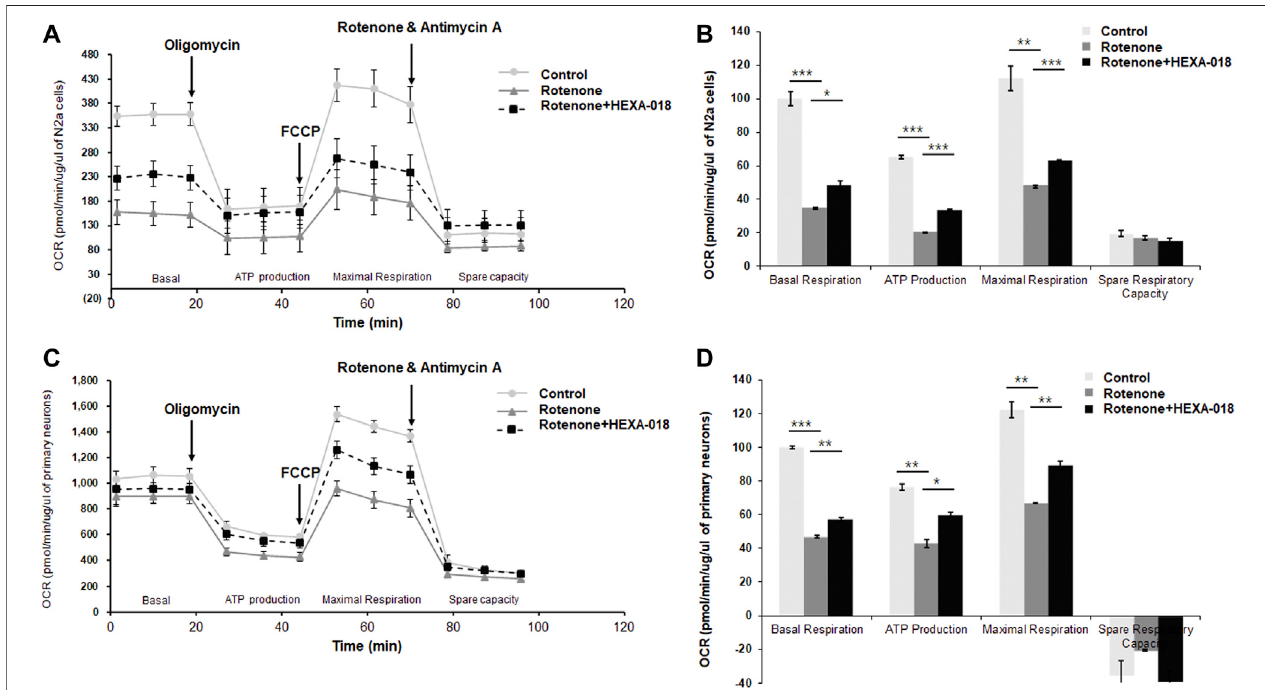
FIGURE 5 | HEXA-018 mitigates rotenone-induced mitochondrial dysfunction in neuronal cells. (A,B) N2a cells were pretreated with HEXA-018 (5 µM) for 30 min and subsequently treated with rotenone (10 μ M) for 24 h and then analyzed. (A) Mitochondrial function was analyzed in N2a cells by detecting the basal OCR, ATP production, maximum reserve, and respiratory capacity with a Seahorse XF analyzer. The OCR was normalized to the total protein concentration. (B) Quanti fi cation of the OCR, ATP production, maximum reserve, and respiratory capacity as percentages of the basal values. Data are presented as the mean ± SD. * p < 0.05; ** p < 0.005; *** p < 0.001 (two-way ANOVA with Tukey ’ s multiple comparison test). (C,D) Primary neurons were pretreated with HEXA-018 (0.5 µM) for 30 min and subsequently treated with rotenone (10 μ M) for 24 h and then analyzed. (C) Mitochondrial function was analyzed in primary neurons by detecting the basal OCR, ATP production, maximum reserve, and respiratory capacity with a Seahorse XF analyzer. The OCR was normalized to the total protein concentration. (D) Quanti fi cation of theOCR,ATPproduction, maximumreserve,and respiratorycapacity aspercentagesofthebasalvalues.Dataarepresentedasthemean ± SD.* p < 0.05;** p < 0.005; *** p < 0.001 (two-way ANOVA with Tukey ’ s multiple comparison